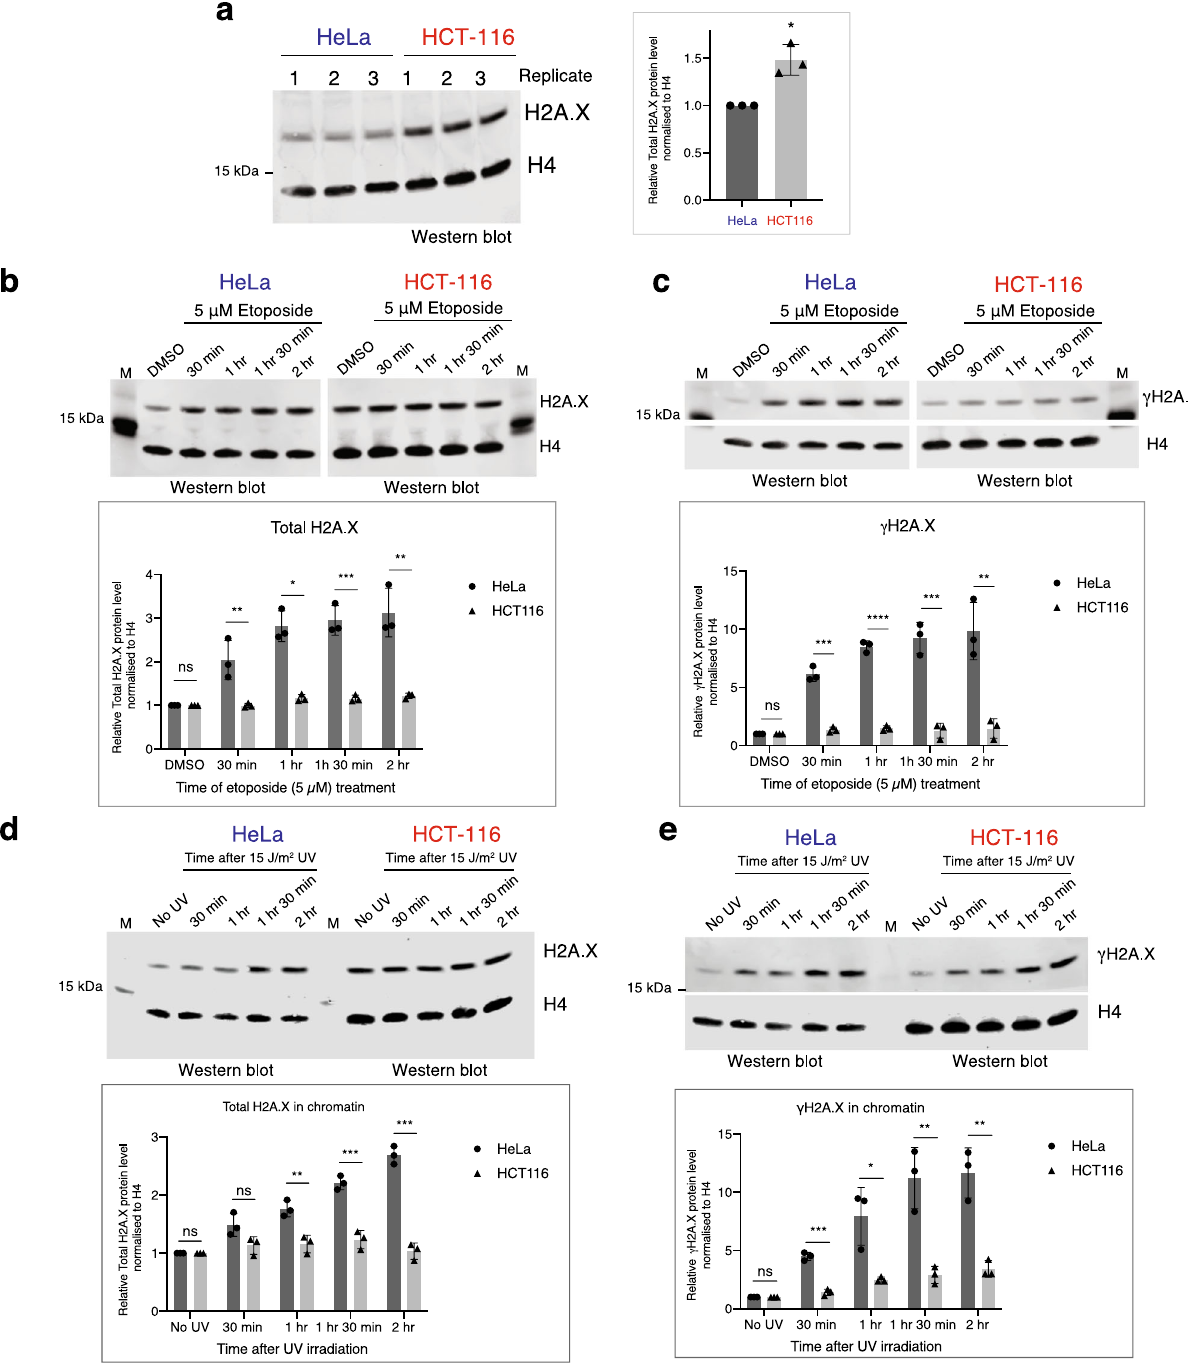
Fig. 4 Analysis of H2A.X deposition in chromatin upon DNA damage induction. a H2A.X levels in chromatin. Western blot of fractionated chromatin from WT HeLa and HCT-116 cells. Total H2A.X and core H4 histone were detected with speci fi c antibodies. Densitometry of western blot (right panel). Total H2A.X protein levels in HCT-116 cells are represented relative to HeLa cells and normalised to H4 histone. Mean ± SD presented for n = 3 independent experiments. Paired Student ’ s t -test, * P -value ≤ 0.05. b Western blot analysis of H2A.X in isolated chromatin from HeLa and HCT-116 cells treated with etoposide as indicated. H4 was used as loading control. M: protein size marker. Mean ± SD presented for n = 3 independent experiments. Unpaired Student ’ s t -test. ns: not signi fi cant P -value >0.05, * P -value ≤ 0.05, ** P -value ≤ 0.01, *** P -value ≤ 0.001, **** P -value ≤ 0.0001. c As in b but for γ H2A.X. d Western blot analysis of H2A.X in isolated chromatin from HeLa and HCT-116 cells after 15 J/m 2 UV irradiation. H4 was used as loading control. M: protein size marker. Mean ± SD presented for n = 3 independent experiments. Unpaired Student ’ s t -test ns: not signi fi cant P -value >0.05, * P -value ≤ 0.05, ** P -value ≤ 0.01, *** P -value ≤ 0.001. e As in d but for γ